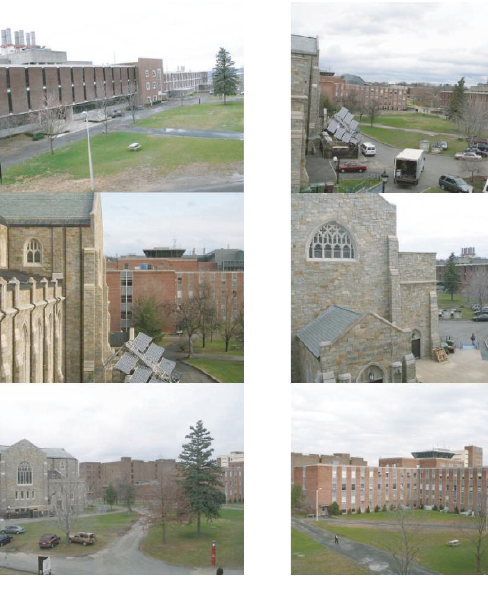
Figure 4: Sample images from the 60-image test set.